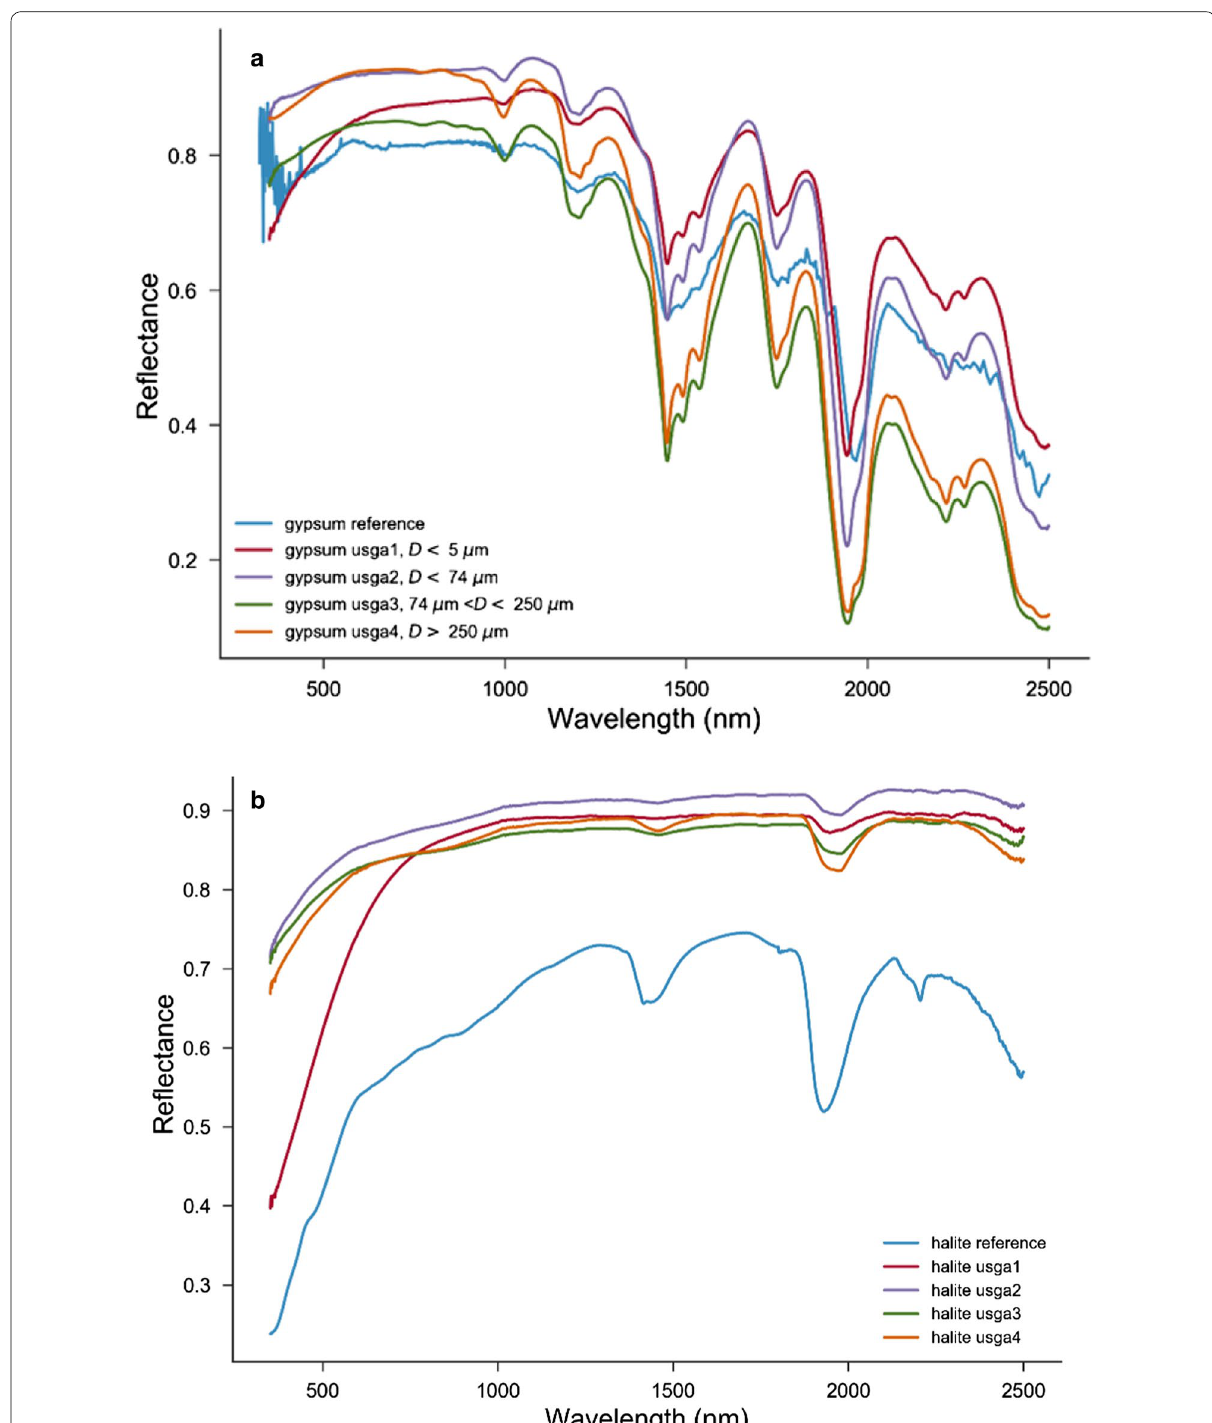
Fig. 2 Spectra of the prepared gypsum ( a ) and halite ( b ) in comparison with the spectra from